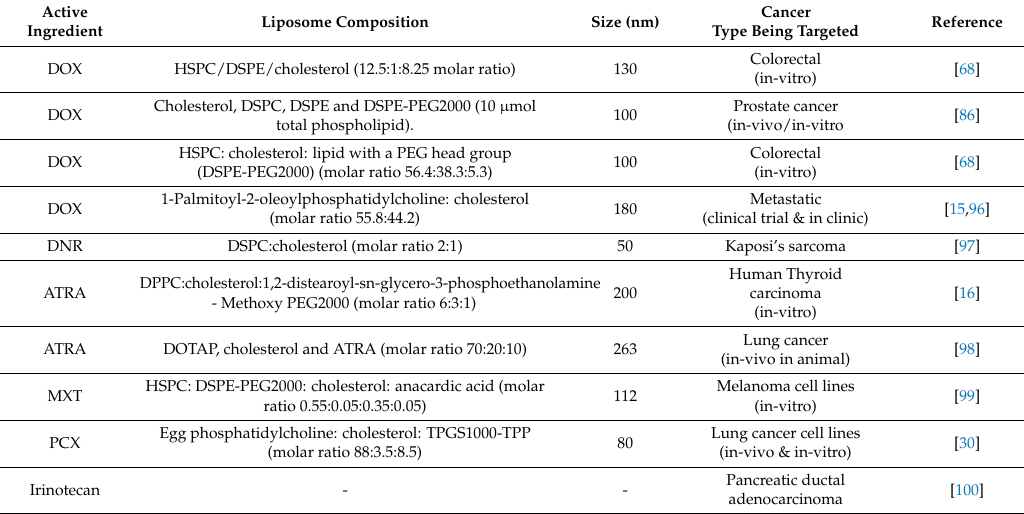
Table 1. Liposomal formulations used as anticancer